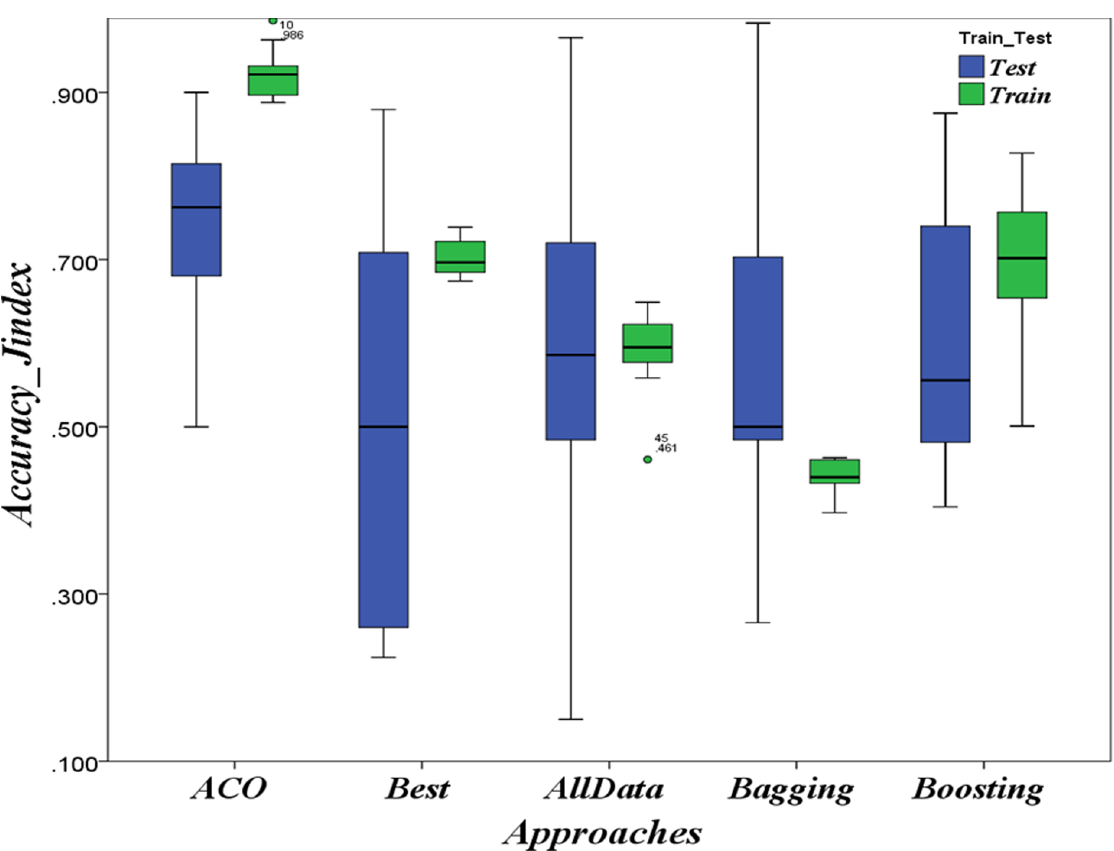
Figure 5. Evaluation in CTG case: Prediction accuracies in the CTG context, ACO-based approach Vs. Best model, data-combination Model, Boosting and